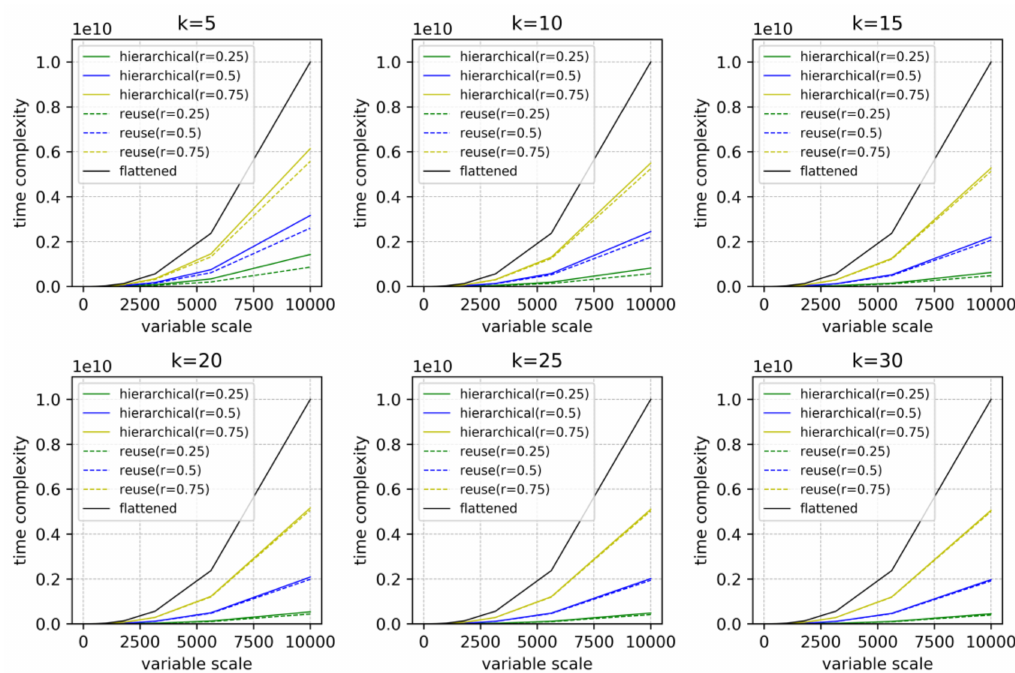
Figure 11. Time complexity comparison of the flattened method and the hierarchical method under different